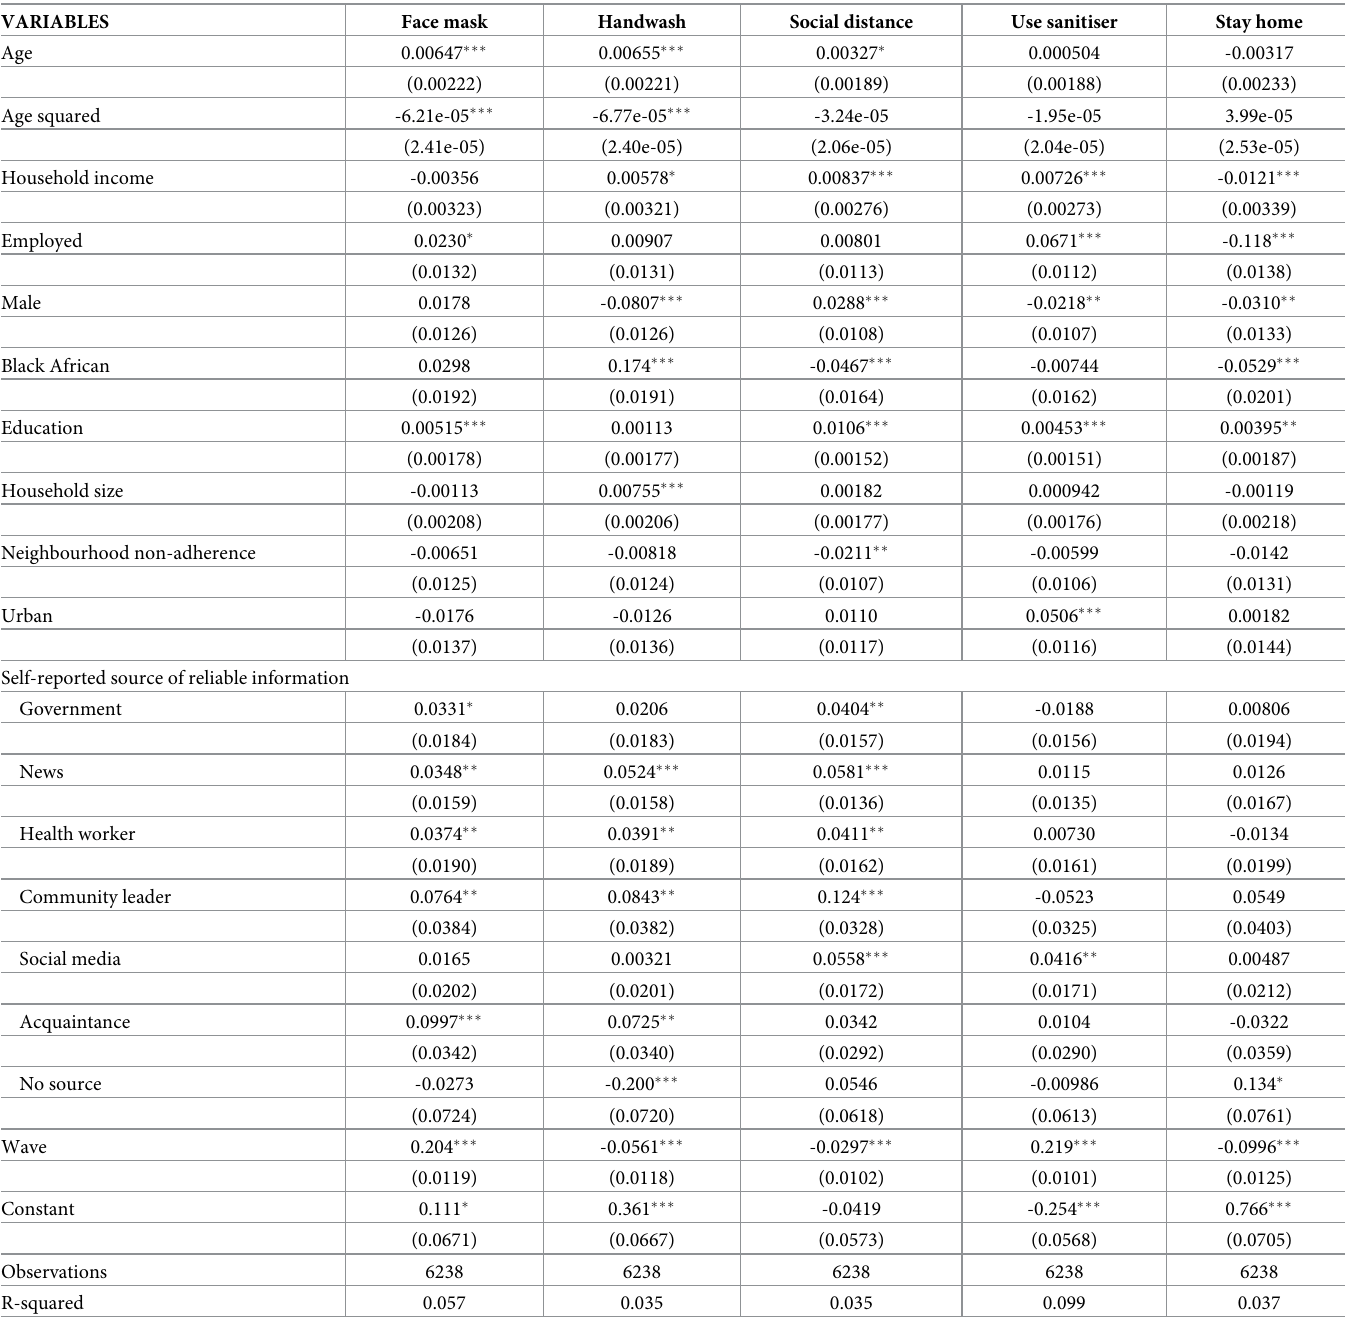
Table 7. Seemingly unrelated regression results (preventive